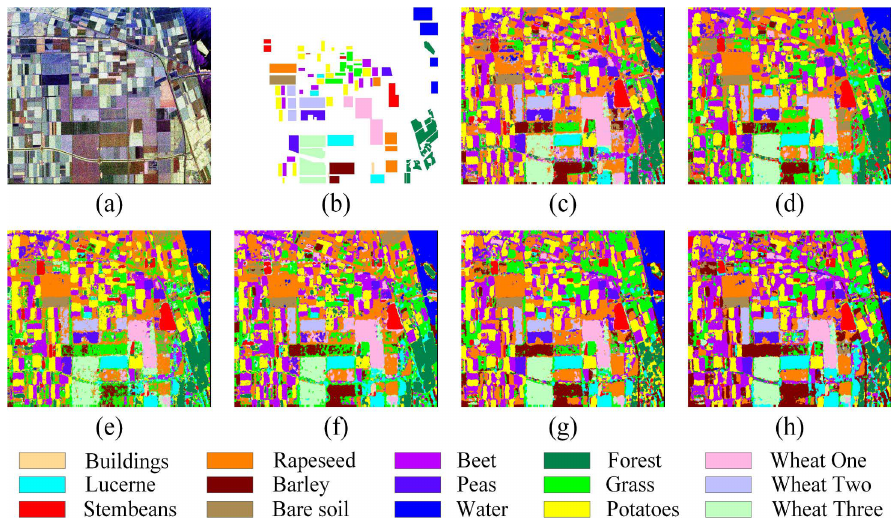
Figure 25. Classification results of whole map on AIRSAR Flevoland [70]: ( a ) Pauli RGB map. ( b ) Ground truth map. ( c ) CNN-v1. ( d ) VGG-v1. ( e ) CNN-v2. ( f ) VGG-v2. ( g ) MCNN. ( h ) DMCNN.